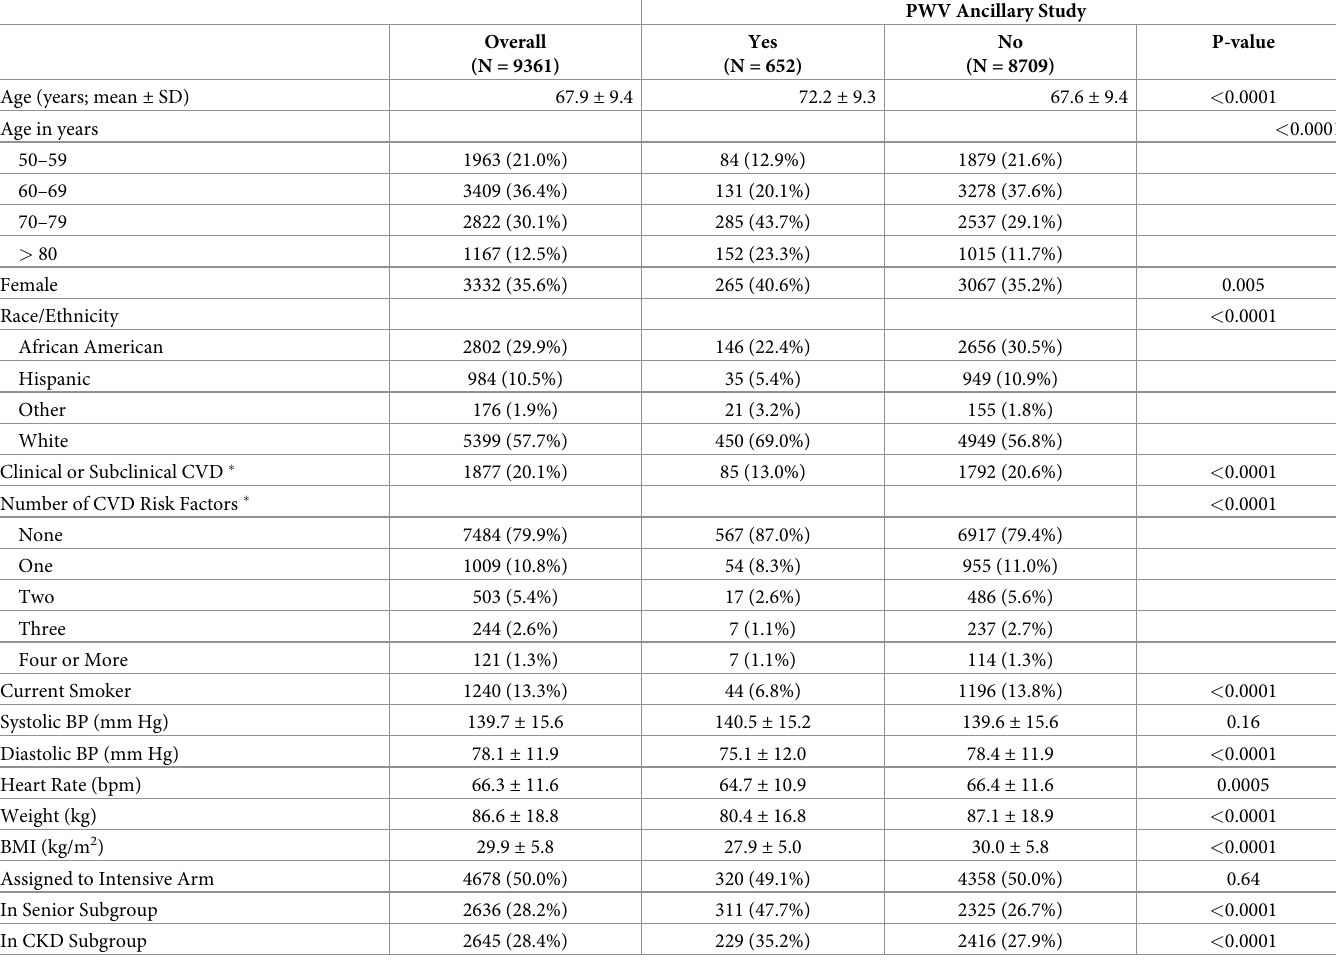
Table 1. Baseline characteristics comparing SPRINT participants in PWV ancillary study to the entire cohort.